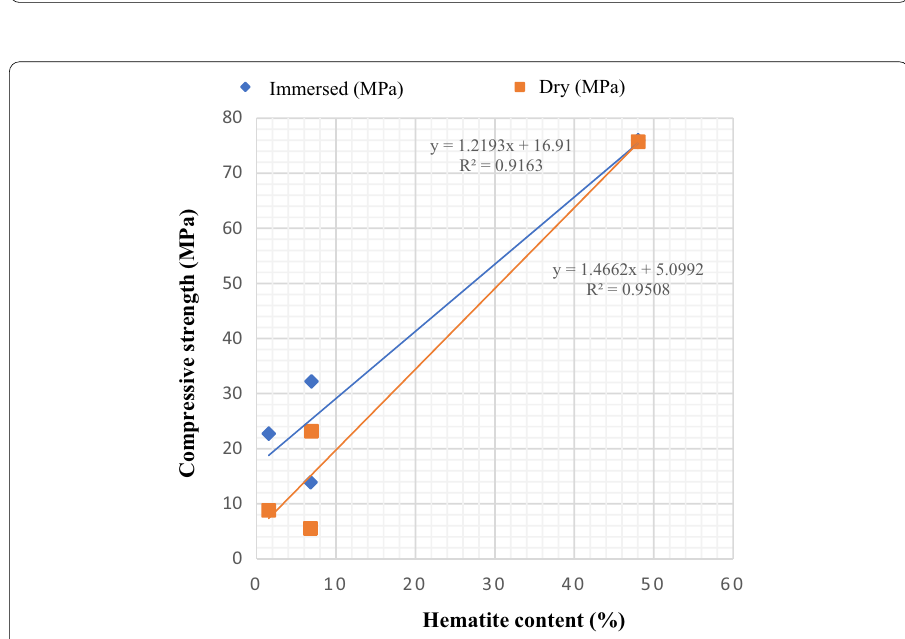
Fig. 11 Influence of Hematite content on dry and immersed compressive